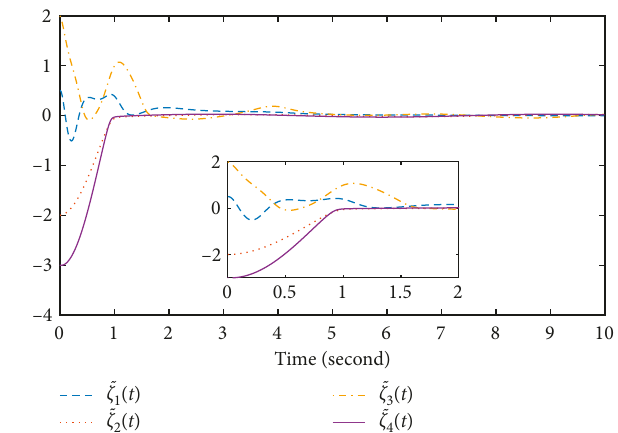
Figure 11: Tracking